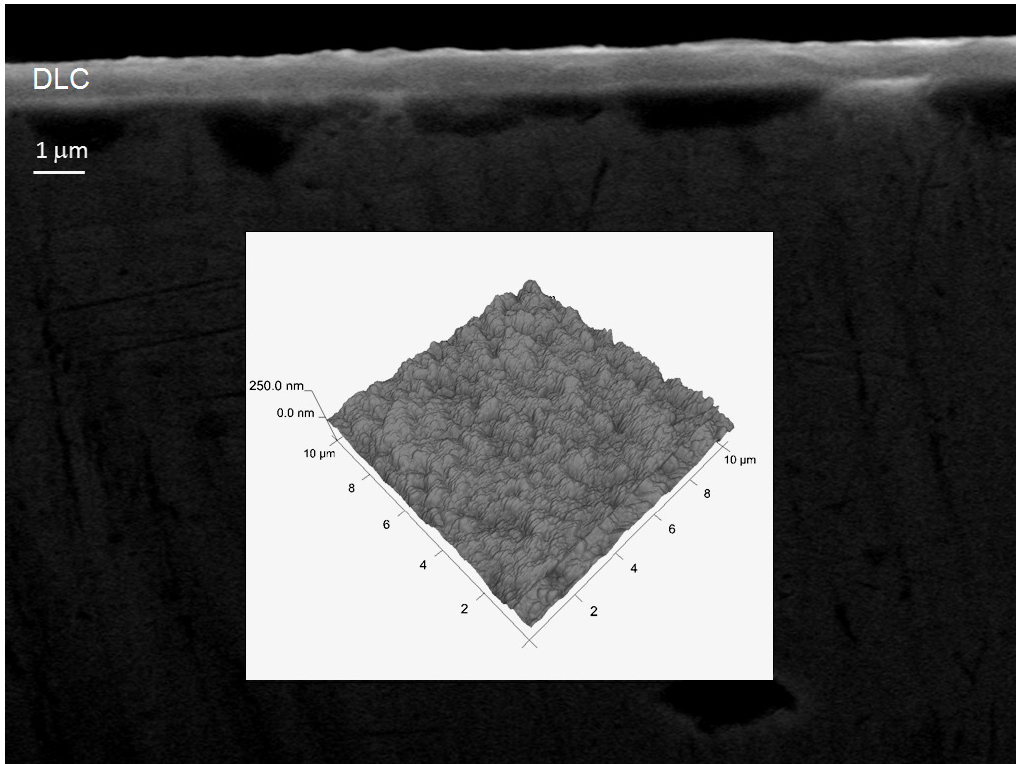
Figure 4. Cross-section view of the thickness of DLC coating by scanning electron microscopy and the morphology of the DLC coating by AFM (inside).